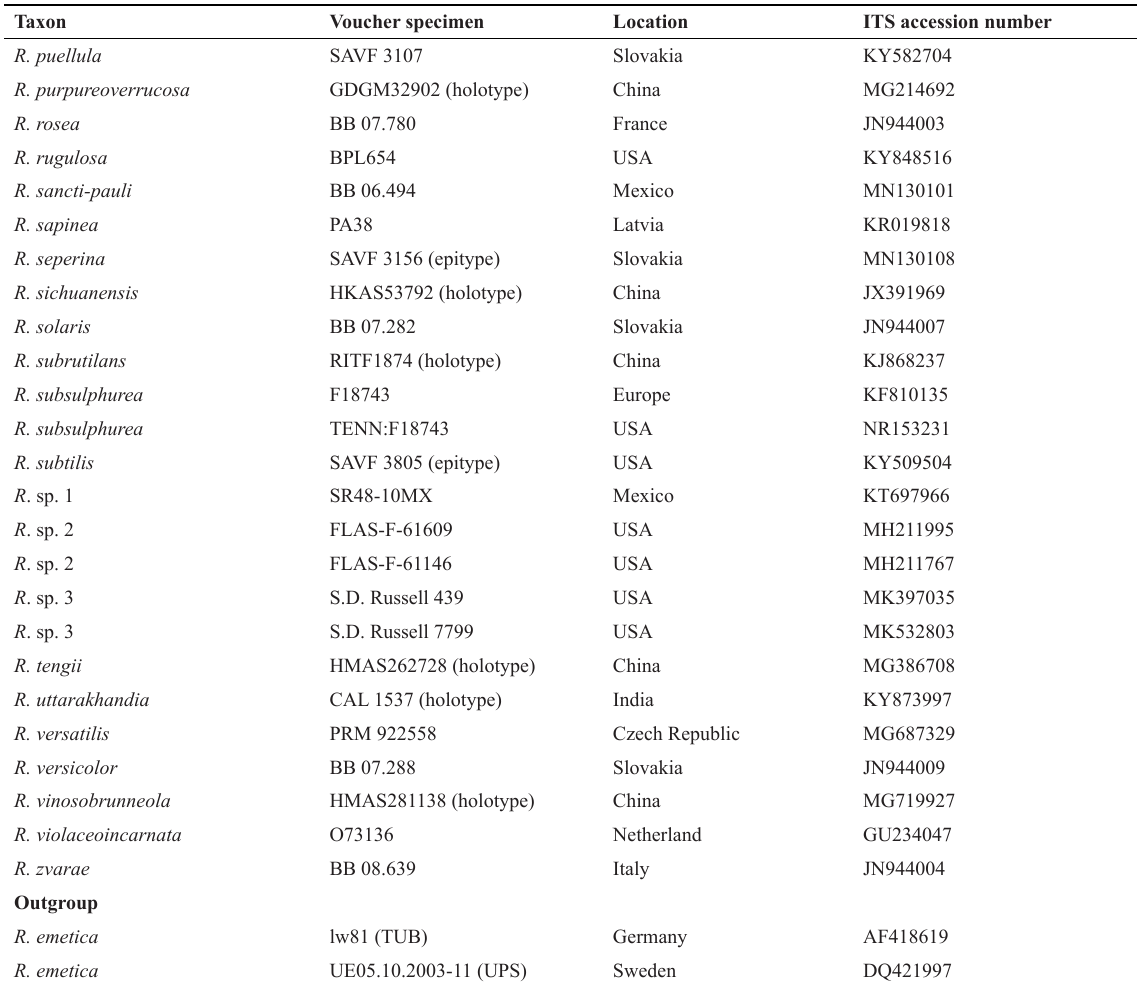
Table 1. Newly generated sequences used in phylogenetic analysis based on ITS. Newly generated sequences are shown in